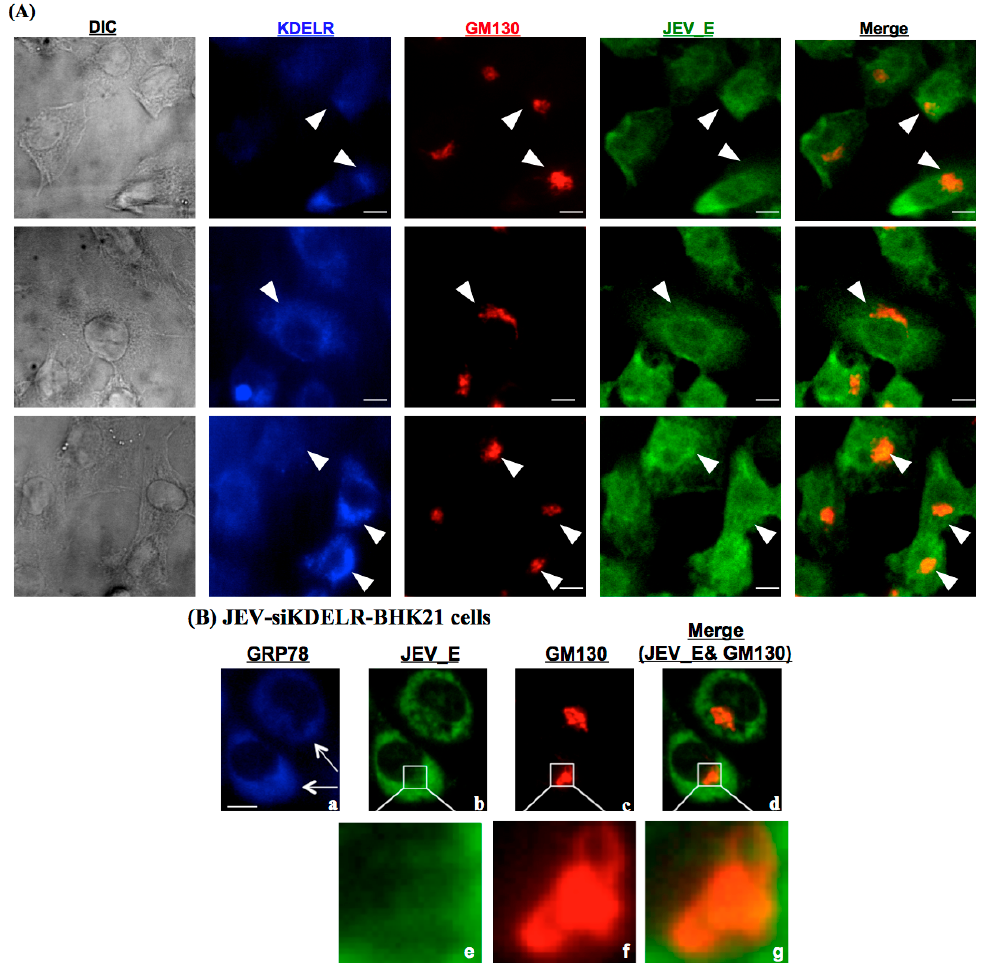
Figure 5. Interaction of KDELR protein and viral E protein was located in the Golgi membrane of JEV-infected cells. The BHK-21 cells were mock-infected or infected with JEV at an MOI of 0.1, followed by fixation and stained with antibodies in preparation for an immunofluorescence analysis that detected JEV viral E protein (green), GM130 (red) and KDELR protein (blue). ( A ) Subcellular localization of GRP78, GM130 and KDELR proteins in the JEV-infected cells. Differential interference contrast determined the cell morphology, as shown in the left panel. The positive stained signals were indicated as the white arrowhead. Bar = 10 µ M; ( B ) The distinct subcellular localization of GRP78, JEV viral E protein and GM130 in the siKDELR-treated and JEV-infected BHK-21 cells. The anti-KDELR siRNA-transfected BHK-21 cells were infected with JEV and then harvested for immunofluorescence analyses with antibodies, as indicated. The positive stained of JEV viral E protein was indicated as the white arrow. Enlarged photos of (b,c,d) are shown in the square areas (e, f, g).